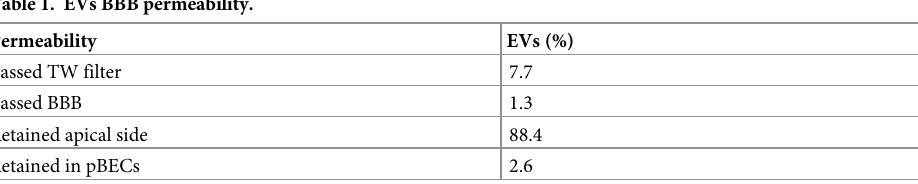
Table 1. EVs BBB permeability.